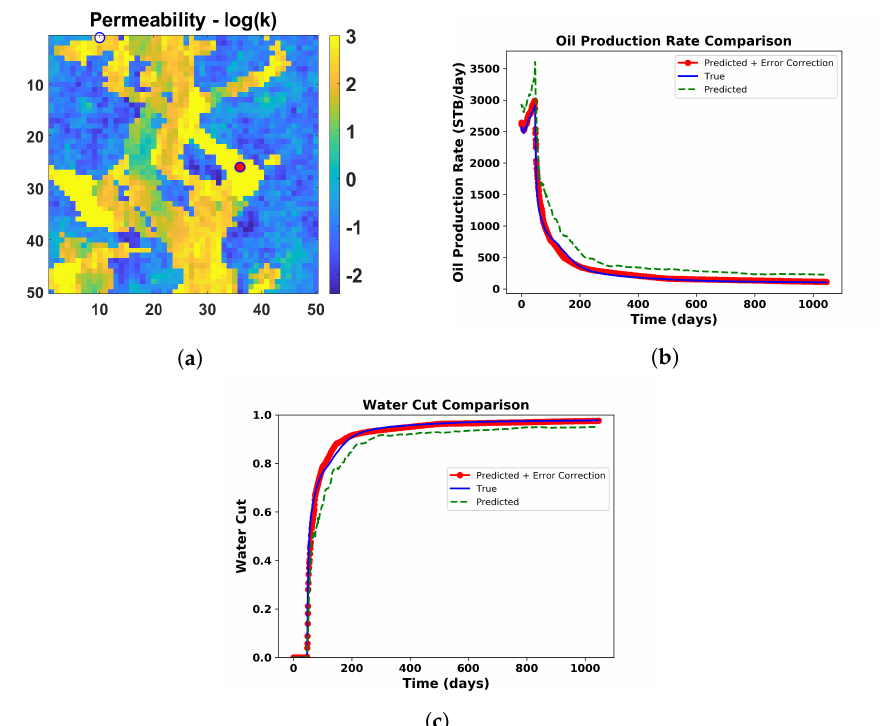
Figure 40. ( a ) Test case 1 with producer well location at (36,26). ( b ) Comparison of oil production rate and ( c ) comparison of water cut, predicted using the global PMOR method alone (dotted green line) and after the implementation of error correction model (red circled line) with the true solution (blue line).